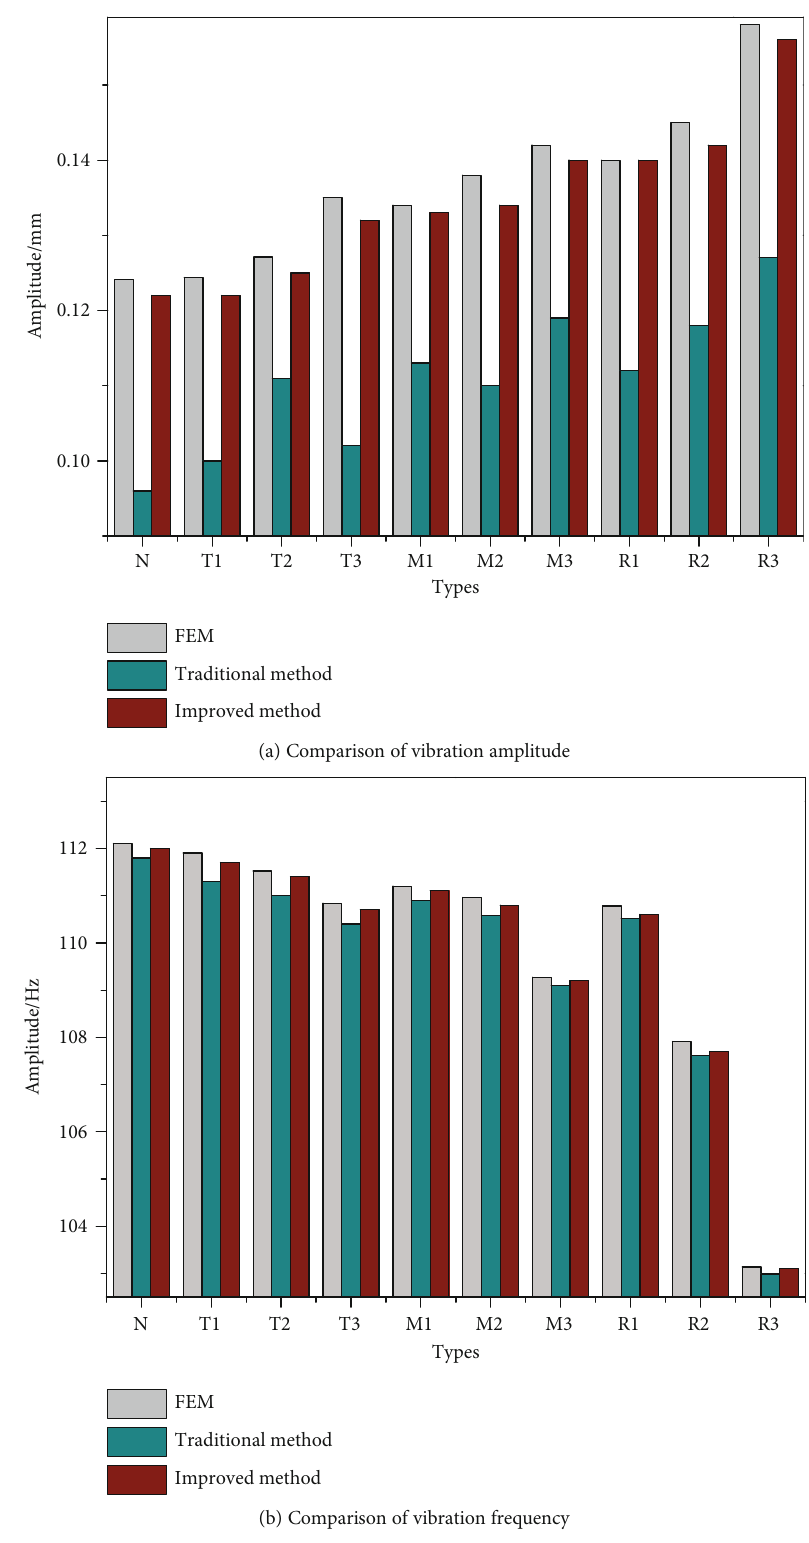
Figure 16: Comparison of vibration response with FEM, traditional method, and improved